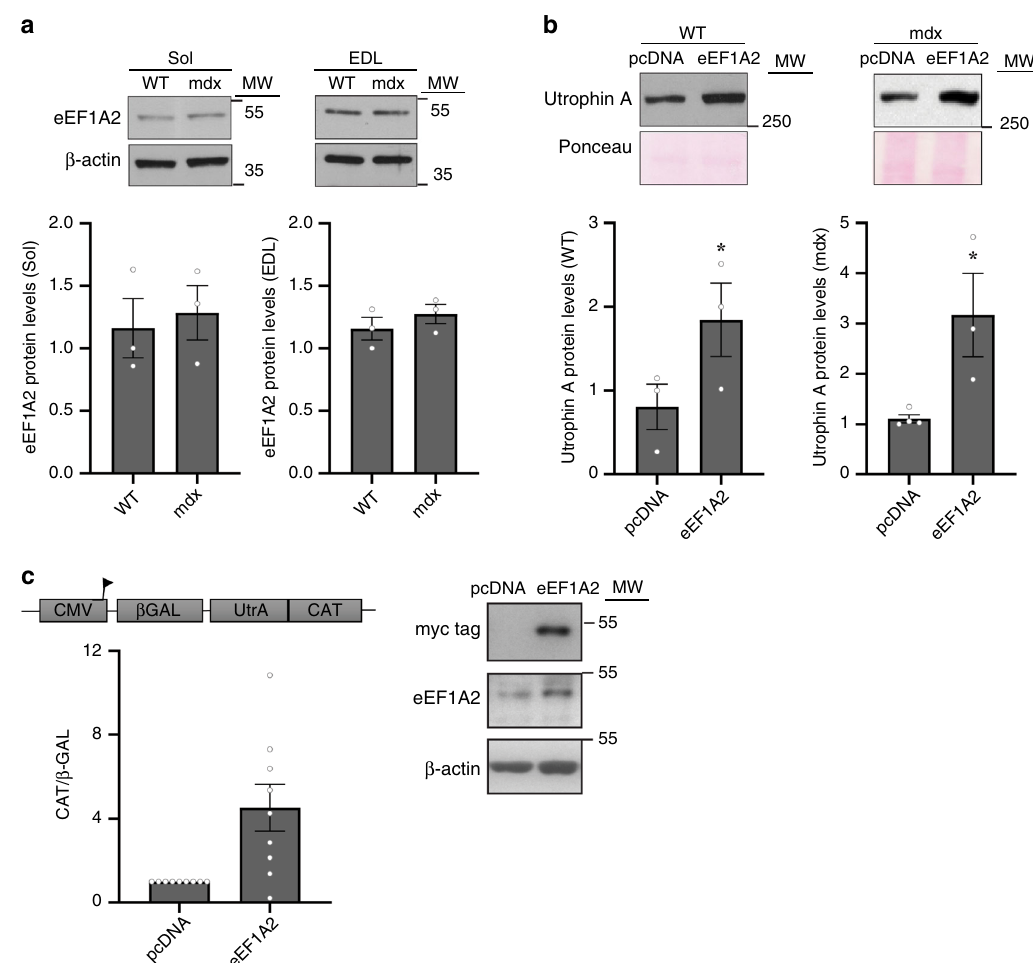
Fig. 1 Overexpression of eEF1A2 in skeletal muscles increases endogenous utrophin A protein levels and utrophin A IRES activity. a Representative western blot comparing the expression pro fi le of eEF1A2 protein in fast (EDL) and slow (soleus) skeletal muscles harvested from 6 to 7-week-old wild-type (WT) and mdx mice. β -actin was used as a loading control ( N = 3). b eEF1A2 (eEF1A2-pcDNA) expression construct or control (pcDNA3.1) were electroporated into TA muscles of wild-type and mdx mice as well as in TA muscles from utrophin A 5 ′ UTR (CMV/ β GAL/UtrA/CAT) reporter transgenic mice. Representative western blots of endogenous utrophin A protein expression in wild-type and mdx mice following overexpression of eEF1A2 with the respective quanti fi cation. Ponceau staining was used as a loading control. Note the increase in utrophin A protein levels in skeletal muscles overexpressing eEF1A2 ( N = 3). c Relative IRES activity as determined by a ratio of CAT: β -GAL activity in TA muscles of utrophin A 5 ’ UTR (CMV/ β GAL/UtrA/CAT) transgenic mice overexpressing eEF1A2 ( N = 9). On the right, representative western blots demonstrating expression levels of the myc tag containing pcDNA-eEF1A2 expression vector and eEF1A2 expression levels in TA transgenic mouse muscle. Error bars represent SEM. * P < 0.05, versus control. Two- tailed Student's t -test were performed to determine statistical differences in these experiments. Source data are provided as a Source Data fi